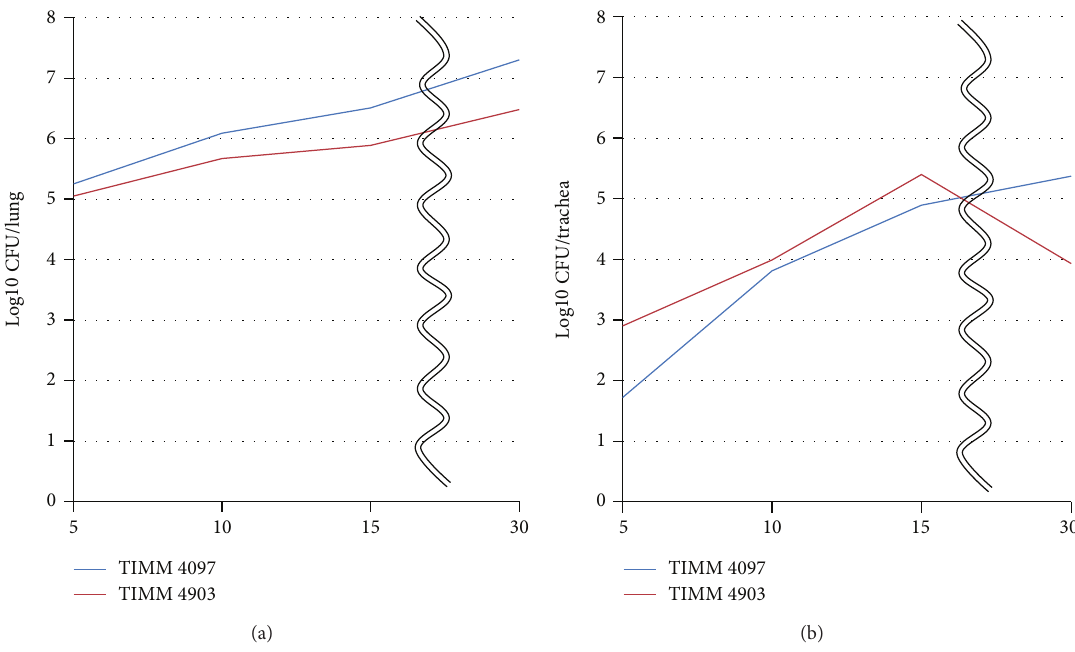
Figure 11: The mean ± SD log 10 CFU/mL counts in the lungs of mice infected with C. gattii TIMM 4097 on days 5, 10, 15, and 30 after infection were 5.25 ± 0.16 , 6.09 ± 0.05 , 6.51 ± 0.12 , and 7.30 ± 0.08 , respectively, similar to those of mice infected with C. gattii TIMM 4903, which were 5.05 ± 0.19 , 5.67 ± 0.14 , 5.89 ± 0.12 , and 6.48 ± 0.24 , respectively. In contrast, the mean ± SD log 10 CFU/mL counts in the tracheae of mice ys 5, 10, 15, and 30 after infection were 1.72 ± 0.54 , 3.81 ± 0.11 , 4.89 ± 0.60 , and 5.37 ± 0.18 , respectively, similar to those of mice infected with C. gattii TIMM 4903, which were 2.90 ± 0.14 , 3.99 ± 0.04 , 5.40 ± 0.10 , and 3.93 ± 0.52 , respectively. Statistical analysis revealed that the mean log 10 CFU count in the lungs of mice infected with C. gattii TIMM 4097 was significantly higher than that of mice infected with C. gattii TIMM 4903 in each evaluation period except for day 5 after infection. Nevertheless, the mean log 10 CFU counts in the tracheae of mice infected with C. gattii TIMM 4903 on days 5, 10, and 15 after infection were significantly higher than those of mice infected with C. gattii 4097.